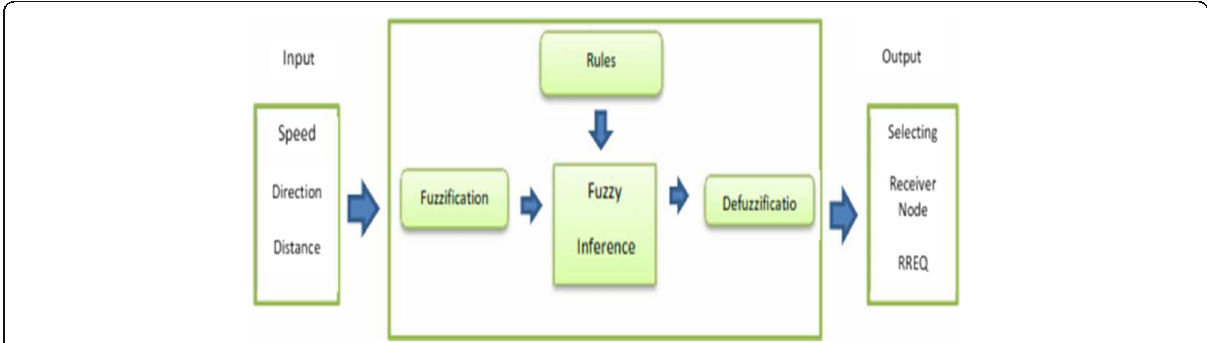
Fig. 3 Fuzzy control system of the proposed protocol. The fuzzy system used in this paper. The main processes of fuzzy logic include fuzzification, fuzzy inference, and defuzzification. Three criteria are used as the input of this system so that a proper conclusion is provided using the fuzzy logic based on this uncertain and inaccurate